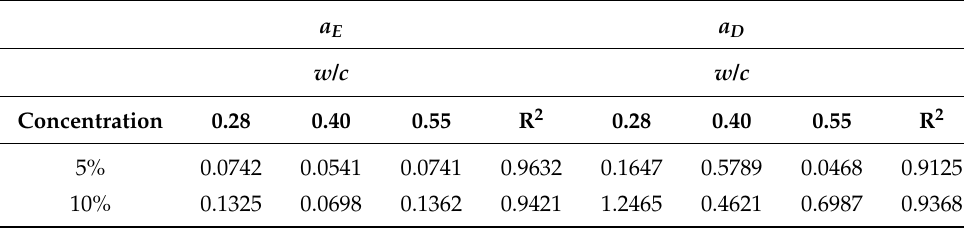
Table 4. Fitting parameters for maximum stress level 0.7 and minimum stress level 0.2.